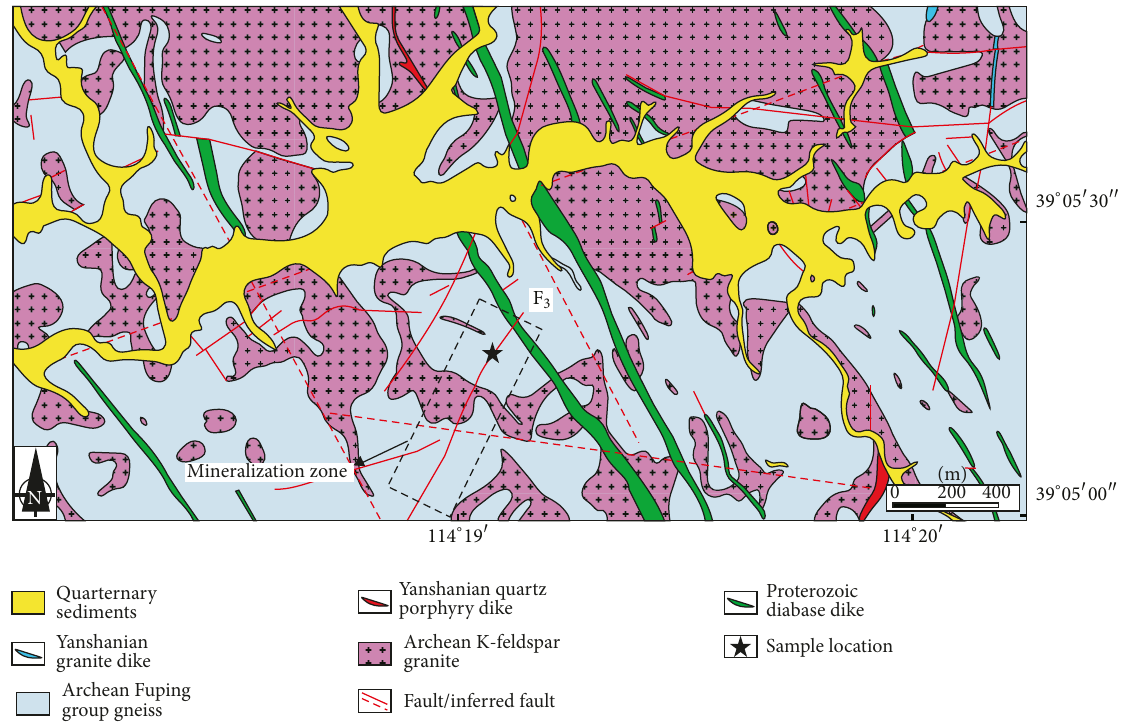
Figure 2: Geological map of the Liyuan gold deposit (modified after Ju et al.